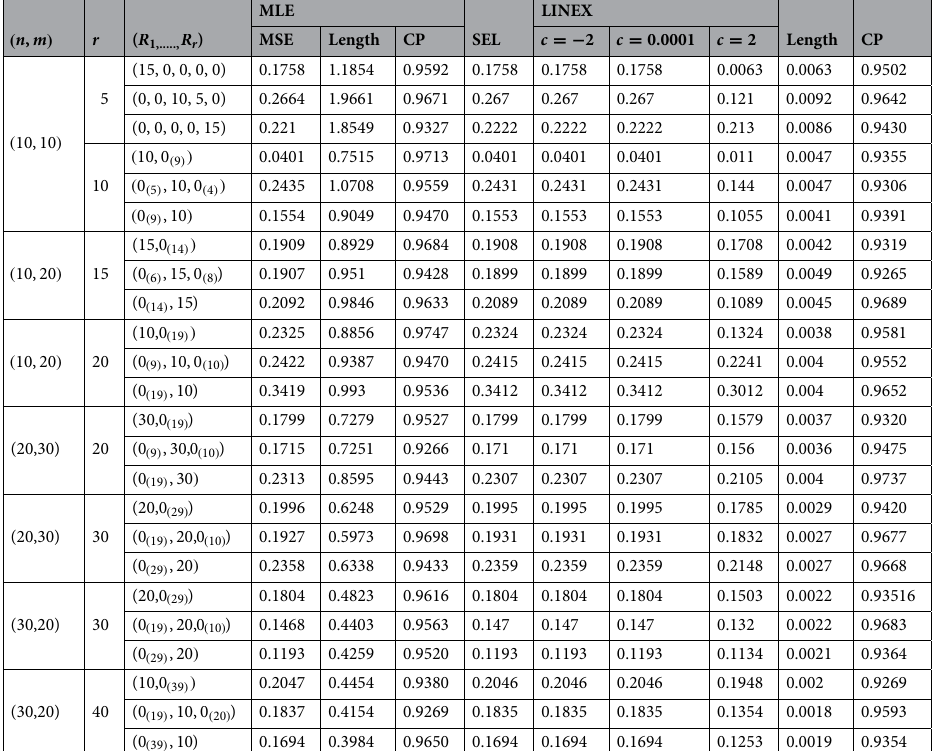
Table 5. MSE, length and coverage probability (CP) of estimates for the parameter α 1 .